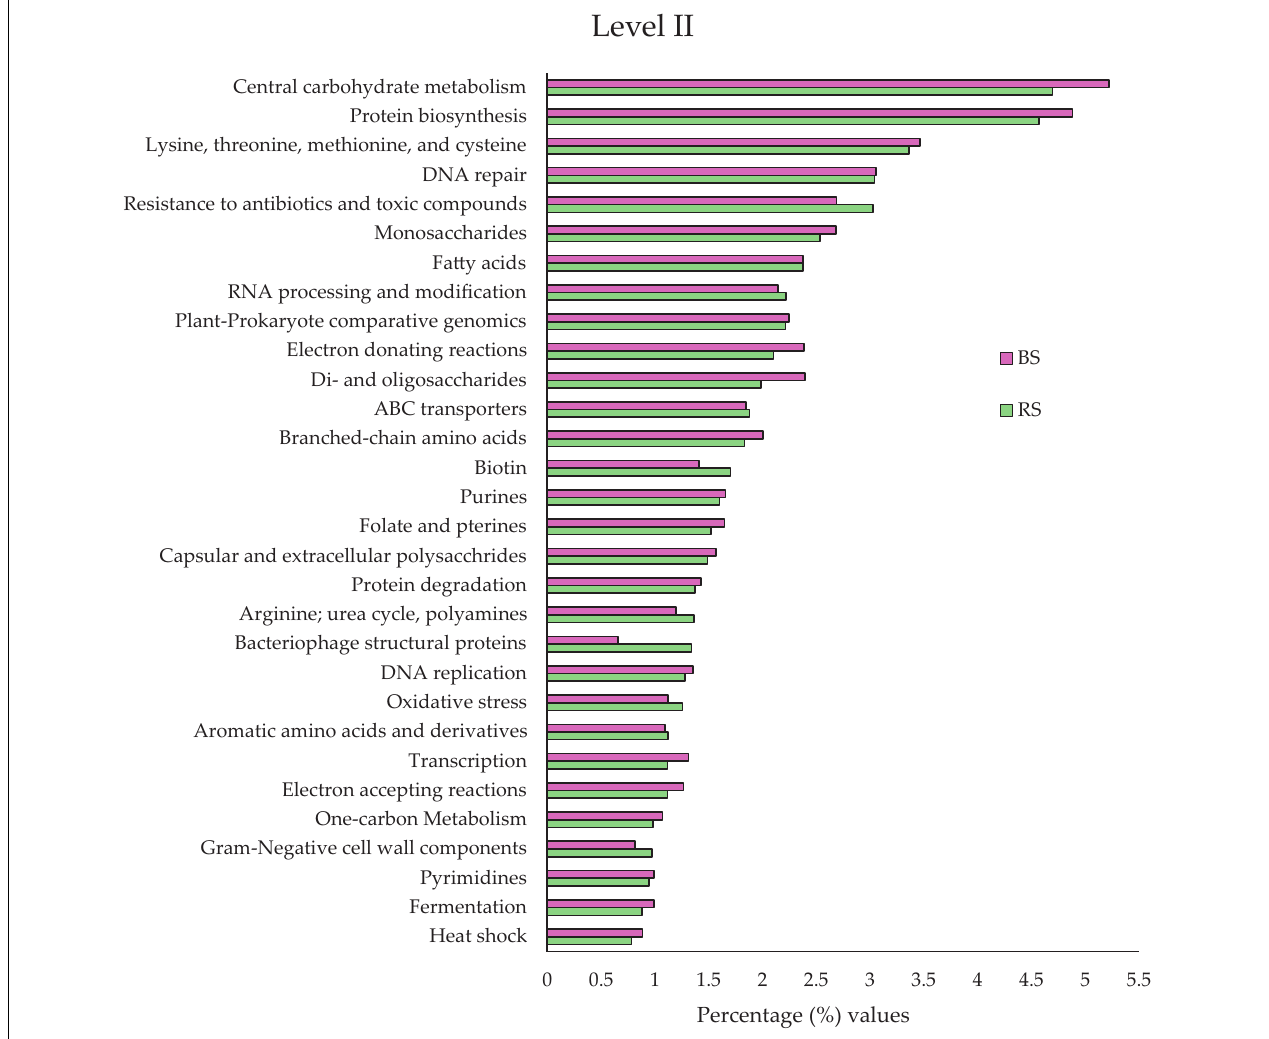
FIGURE 3 | Comparison of the relative abundances of the 30 most abundant functional types in BS (pink bars) and RS (green bars) in level II, all the information at that level could be found in Supplementary Table 3 . All the values are expressed in percentages.